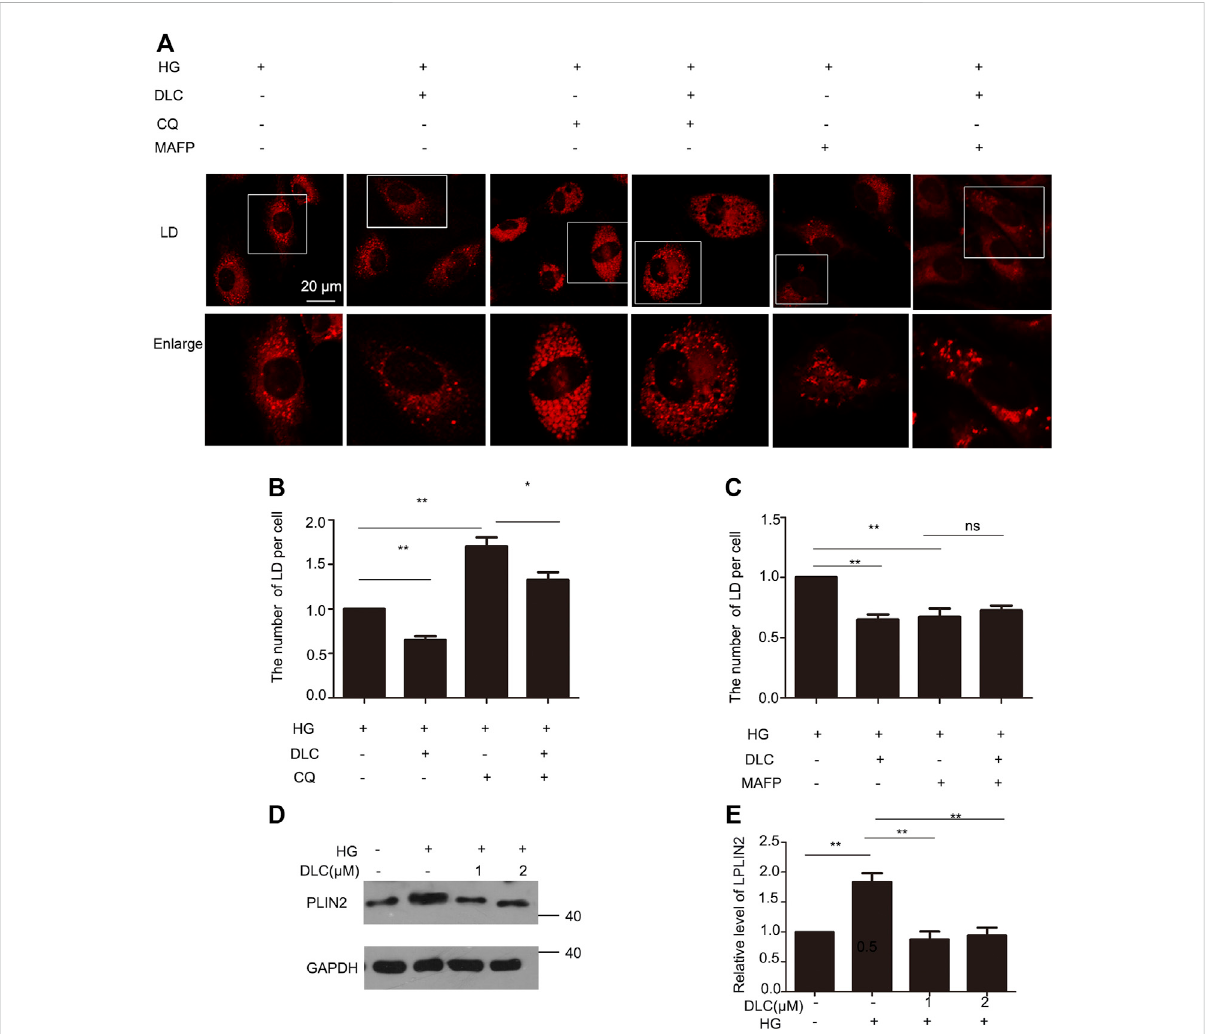
FIGURE 4 DLC promoted degradation of LDs. (A,B) HUVECs were treated with or without MAFP (1 μ M) and DLC (1 μ M) for 24 h. LDs were stained with neutral lipid stain and counted by ImageJ. (C,D) HUVECs were treated with or without CQ (20 μ M) and DLC (1 μ M) for 24 h. LDs were stained with neutral lipid stain and counted by ImageJ. Scale bar, 20 μ m. Data are mean ± SEM; (D,E) : HUVECs were treated with DLC (1, 2 μ M) under HG condition (30 mM) for 24 h and protein levels of PLIN2 was determined by Western blot. Scale bar: 20 μ m, * p < 0.05, ** p < 0.01, n =